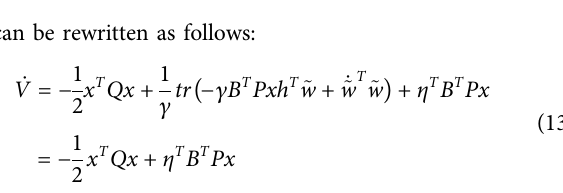
FIGURE 9 | Response of anti-disturbance system based on sliding mode